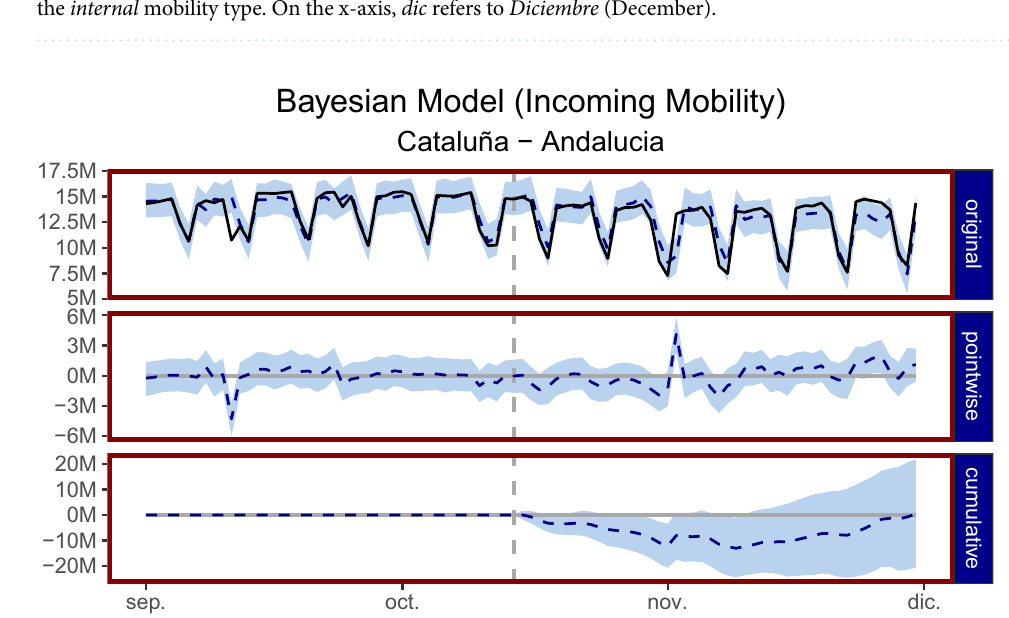
Figure 13. Bayesian structural time-series model: this figure follows on from Fig. 7 in which we report a case where the control was not suitable for Cataluña. The pairwise differences hover around zero and the cumulative mobility returns to zero suggesting that causal inference cannot be inferred from this control group. As Table 6 shows, Andalucia is not statistically significant and the sign of the relative effect is positive, not negative as one would expect. On the x-axis, dic refers to Diciembre